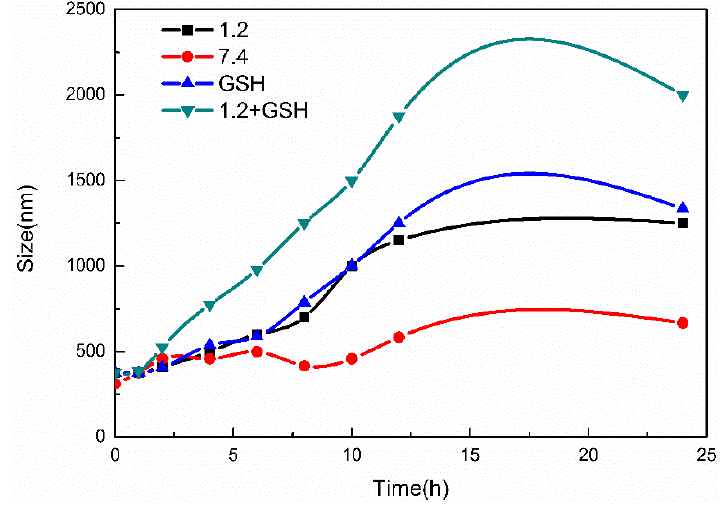
Figure 6. Particle size changes of MSN-S-S-CS in different buffer solutions. Table 3. Changes in particle size and potential of MSN and MSN-S-S-CS in C 2 H 5 OH.